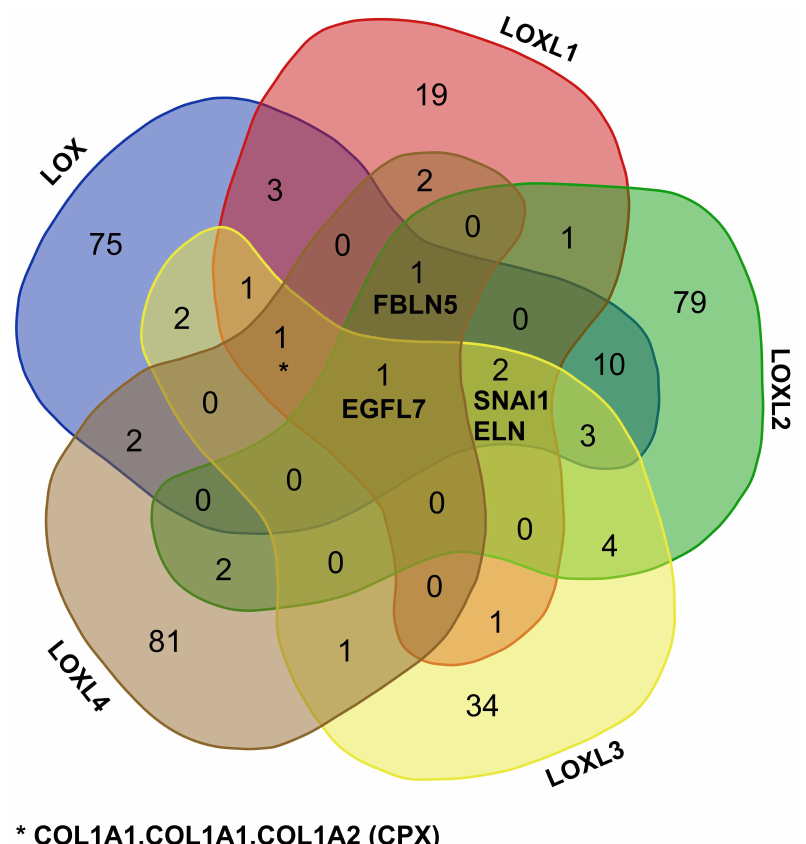
Figure 3. Partners shared by the members of the LOX family. EGFL7: epidermal growth factor-like protein 7, ELN: elastin, FBLN5: fibulin-5, SNAI1: zinc finger protein SNAI1 (Protein snail homolog 1), CPX: complex (e.g., collagen I comprised of two α 1(I) and one α 2(I)